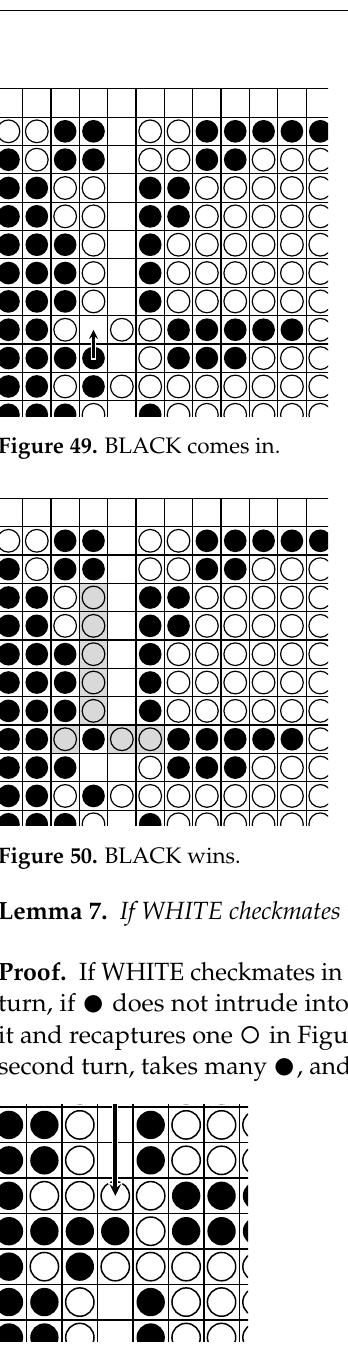
Figure 51. WHITE checkmates.